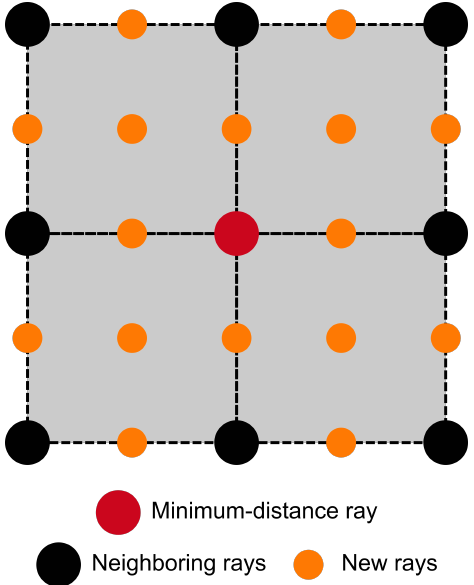
Figure 3. Wavefront formed by rays considered during one iteration of the adaptive ray zooming approach as well as additionally launched